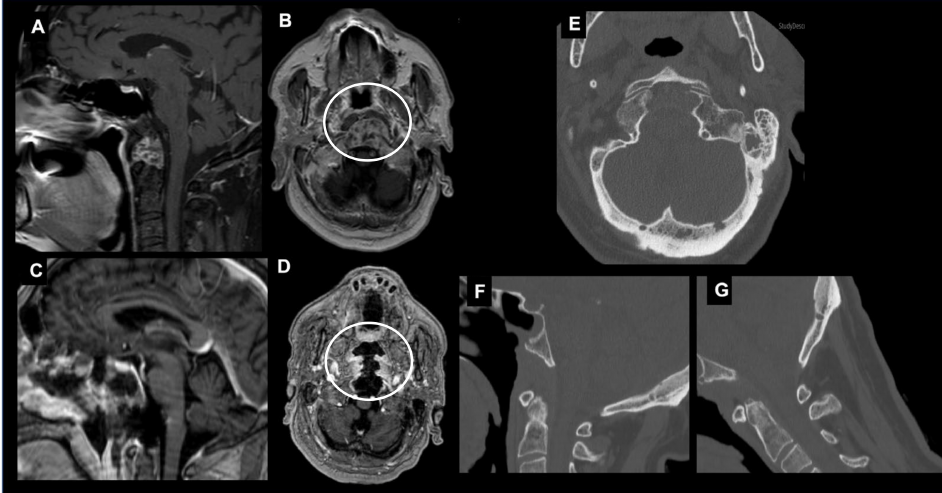
Figure 4. Endoscopic endonasal approach (EEA) to a CVJ chordoma. Sagittal ( A ) and axial ( B ) T1-weighted images after contrast injection showing a craniovertebral junction chordoma invad- ing the C1 anterior arch, transverse ligament and tip of the odontoid. The patient underwent a gross total removal through an EEA. Postoperative sagittal ( C ) and axial ( D ) T1-weighted images after contrast injection confirmed the entity of resection and the integrity of C1-C2 joint. ( E ) Axial CT scan showing the occipital condyle integrity >90%. Dynamic cervical spine CT scans in maximal extension ( F ) and flexion ( G ) showing no abnormal movements and excluding any postoperative CVJ